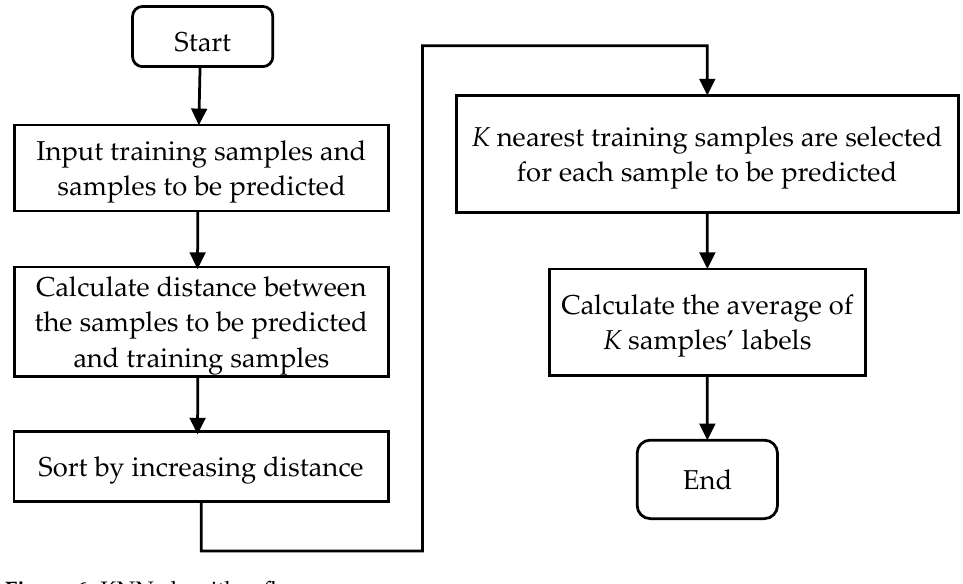
Figure 6. KNN algorithm flow.